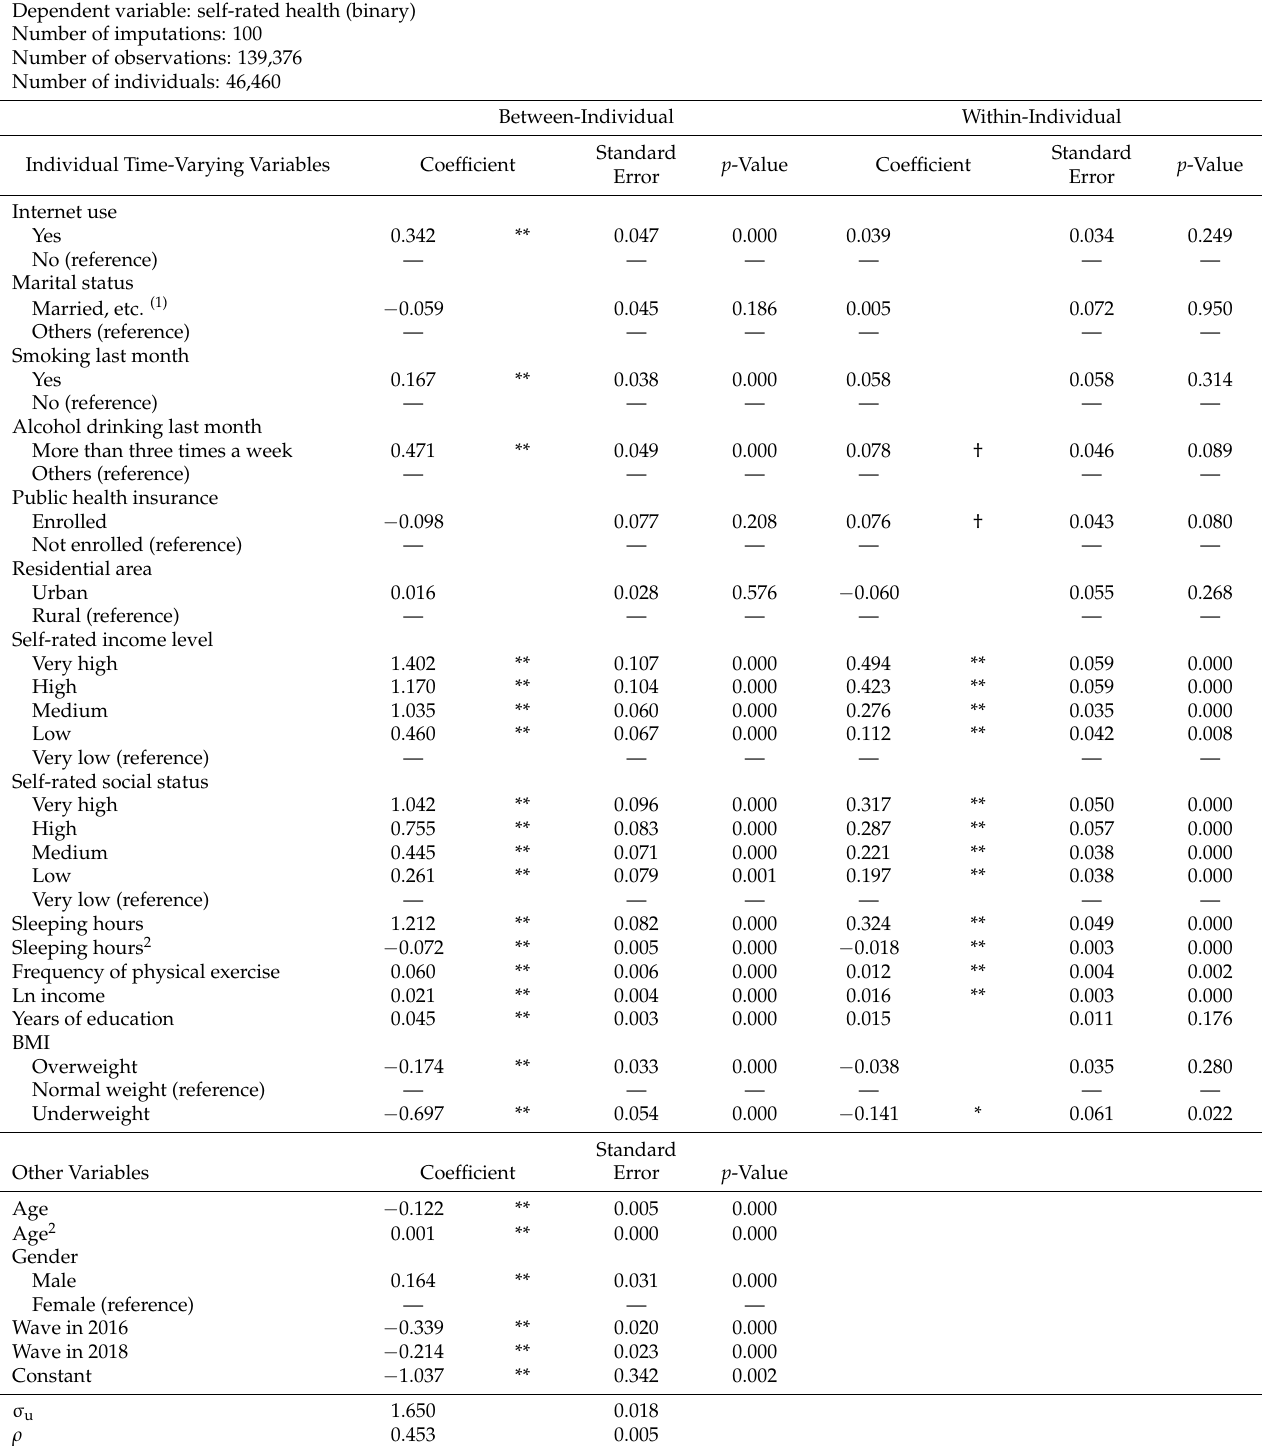
Table 3. Results of the hybrid